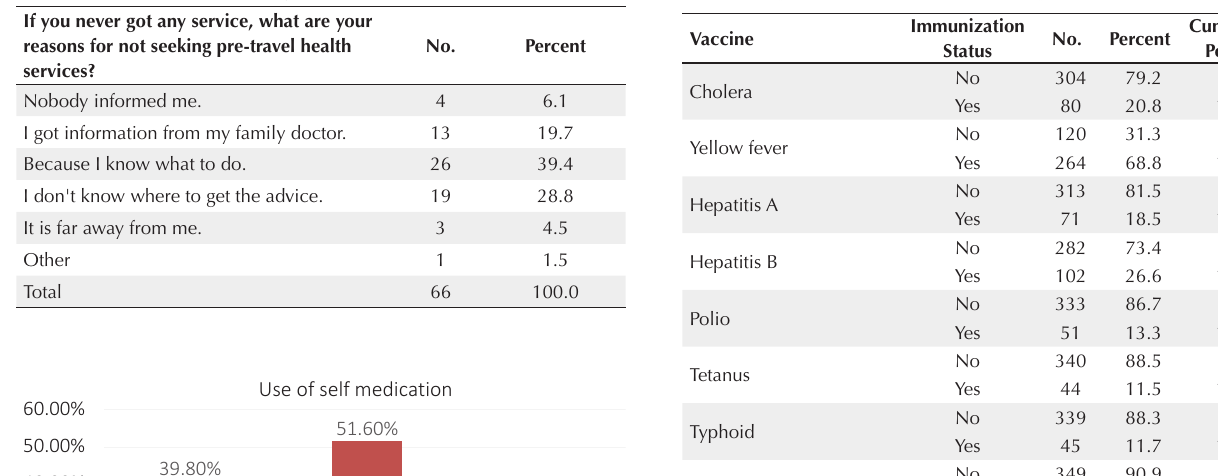
Table 11. Types of Vaccines Received by Respondents Prior to